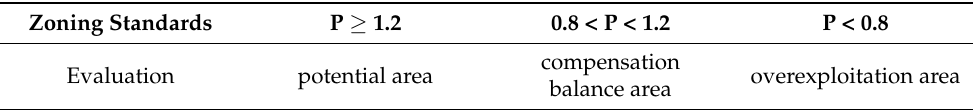
Table 2. Evaluation criteria for brine resource potential.